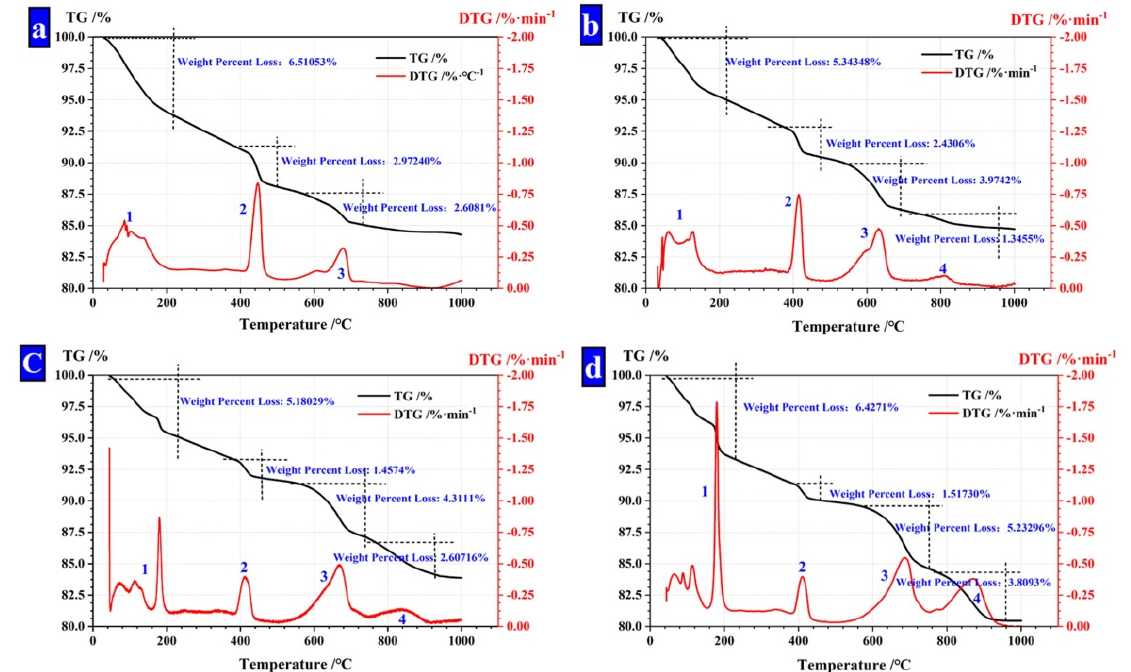
Figure 8. TG analysis of CHPs. ( a ) CHPs with 0% NaCO 3 ; ( b ) CHPs with 5% NaCO 3 ; ( c ) CHPs with 10% NaCO 3 ; ( d ) CHPs with 15% NaCO 3 . Table 5. The mass fraction of unreacted Na 2 CO 3.